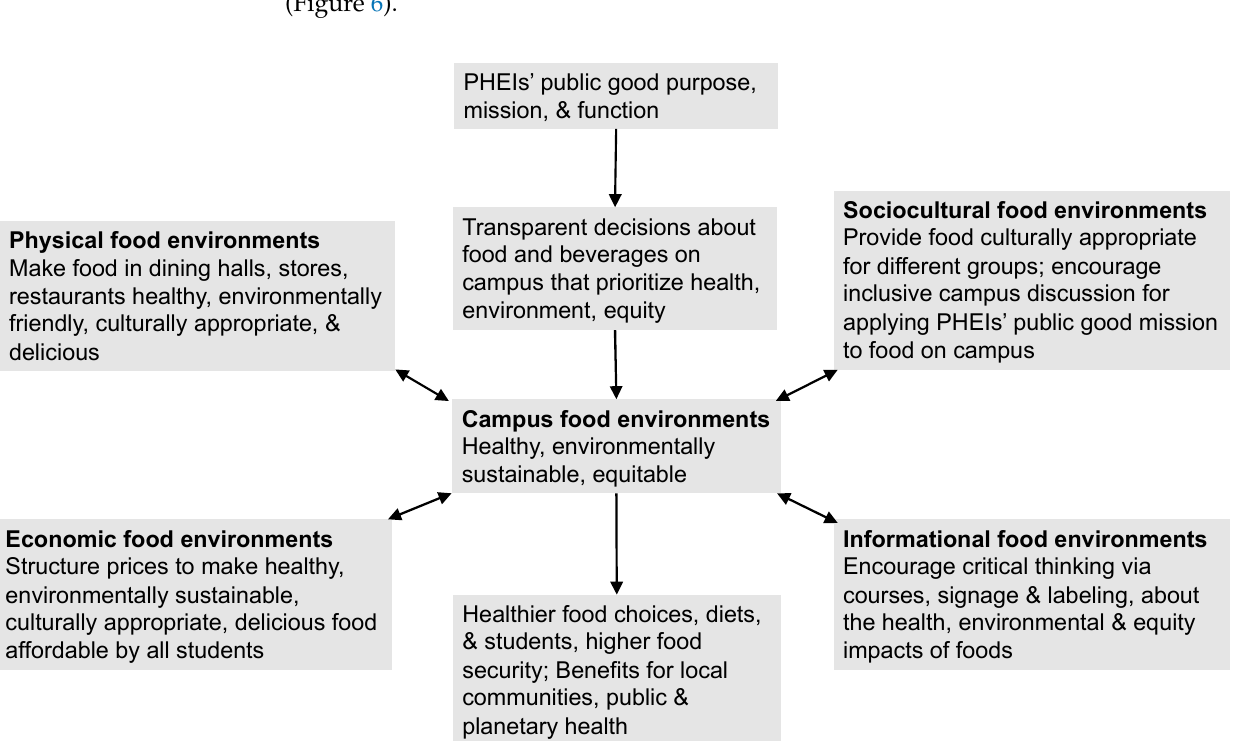
Figure 6. Aligning campus food policy with PHEIs’ public-good purpose, mission and function to transform campus food environments. © D.A. Cleveland, used with permission.